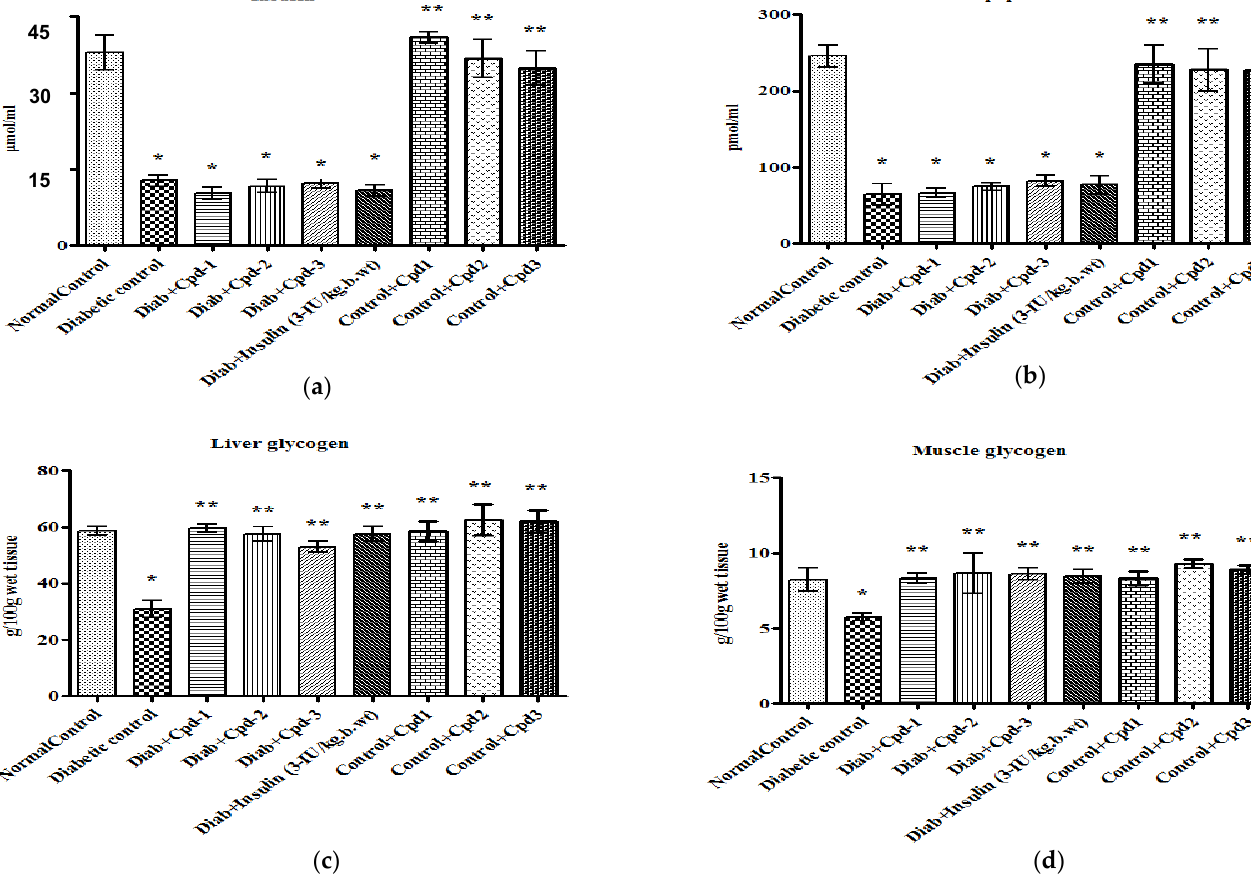
Figure 3. Effect of novel triterpenoids on ( a ) plasma insulin; ( b ) C-peptide; ( c ) liver glycogen; ( d ) muscle glycogen in STZ-induced diabetic rats compared with the effect of insulin. Each bar represents mean ± SEM of 6 animals. Significance at p < 0.05; *, compared with control; **, compared with diabetic control.